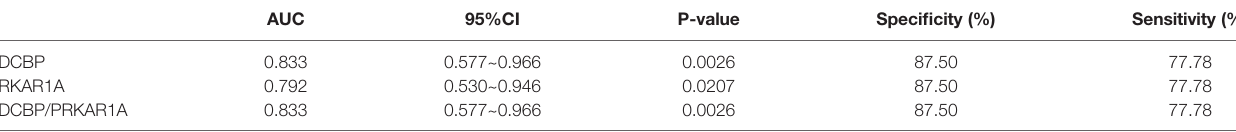
TABLE 2 | Receiver operating characteristic curves in